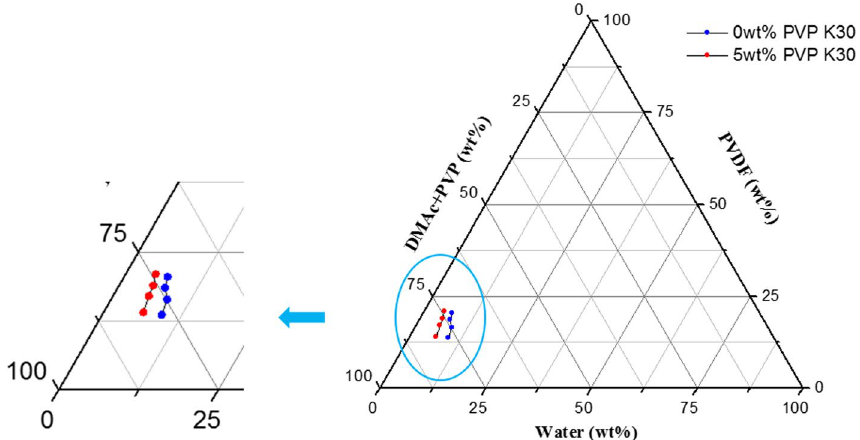
Fig. 3 The PVDF/PVP/DMAc/ water phase